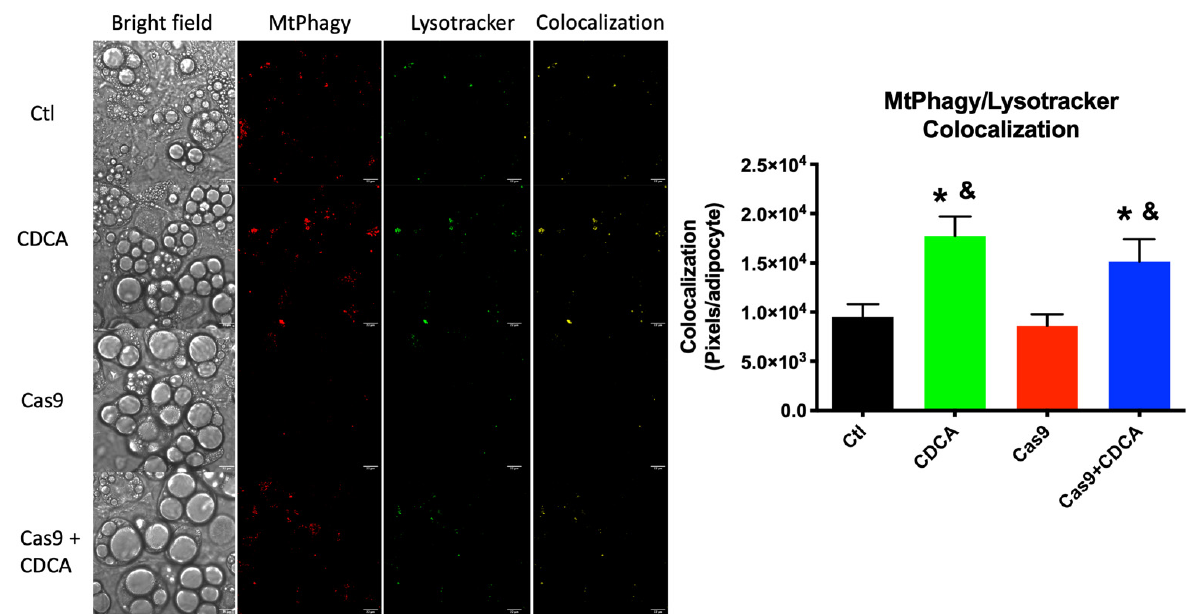
Figure 6. Mitophagy evaluation on 3T3-L1 adipocytes exposed to CDCA in the absence or presence of TGR5. Fluorescence microscopy representative images of the various experimental conditions, when observed under white light or evaluating fluorescent signal of the two probes, MtPhagy and Lysotracker Green. A fourth panel indicates the fluorescence signals’ colocalization where it happens, where it is represented in yellow. Scale bars in microscopy photographs represent a distance of 22 µ m. Microscopy figures contrast settings were all maxed solely to gain visual clarity and long after image analysis. Bars represent means ± SEM of at least 185 individually quantified adipocytes. * indicates a statistically significant difference vs. Control ( p < 0.05); & indicates a statistically significant difference vs. Cas9 ( p < 0.05).